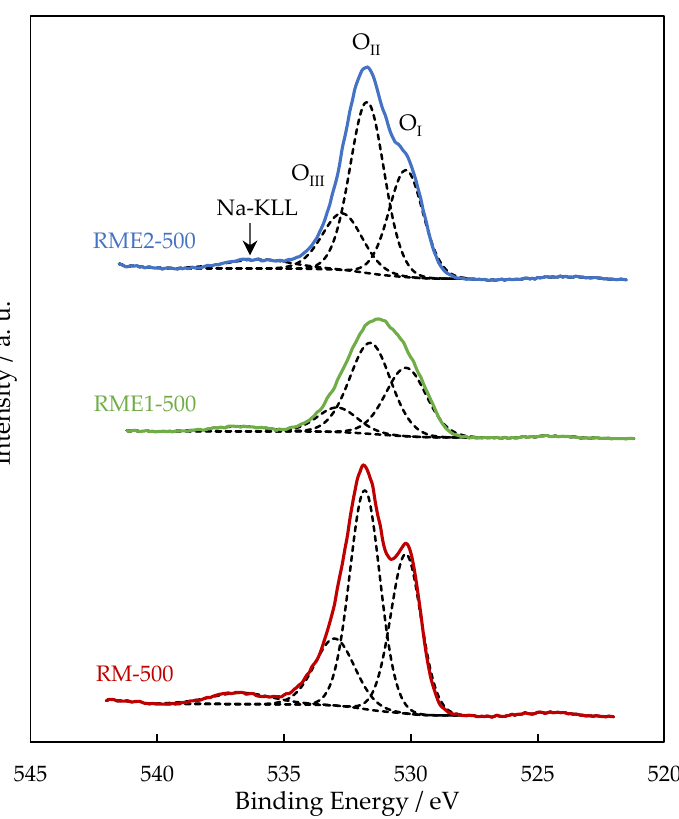
Figure 4. High-resolution O1s XPS spectra deconvoluted peaks for the RM and RME samples. Quantitative information is shown in Table 4, along with Fe/Al atomic ratios. The surface iron content increases marginally for RME2-500 compared to RM-500, while in the case of RME1-500, there is a reduction. This is similar to the trend in bulk composition (Table 1). Correspondingly, the Fe/Al atomic ratio is increased for RME2-500 and decreased for RME1-500, compared to RM-500 for both surface composition and bulk composition. The RME1-500 sample shows high Cl content, which corresponds with the presence of NaCl detected in XRD analysis (Figure 2b). Table 4. Atomic percentage of elements from XPS analysis (at %) for the RM and RME samples.